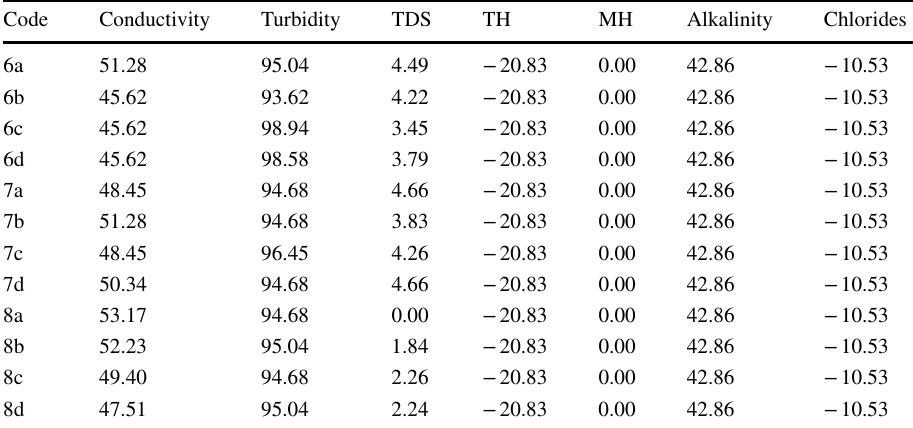
in various physicochemical parameters of surface water after treatment with blended coagulant (alum + chitin—1:3 ratio)